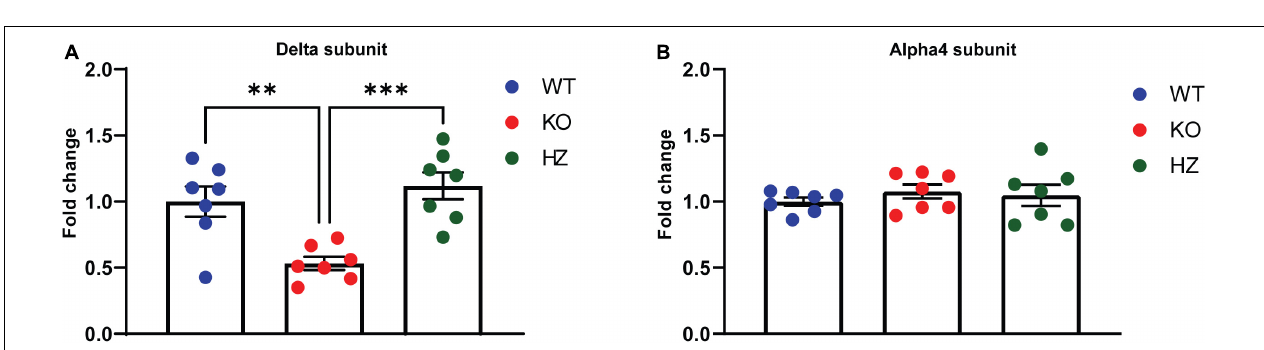
FIGURE 3 | GABA A receptor s measurement in different brain areas revealed a homeostatic change in the hippocampus of GABA B ( 1 ) KO. mRNA level of the delta (A) and alpha4 (B) subunits in the hippocampus of GABA B ( 1 ) WT, KO, and HZ mice. Post hoc test ( ∗∗∗ p < 0.001; ∗∗ p < 0.01) ( n = 7/group). All data are expressed as mean ±